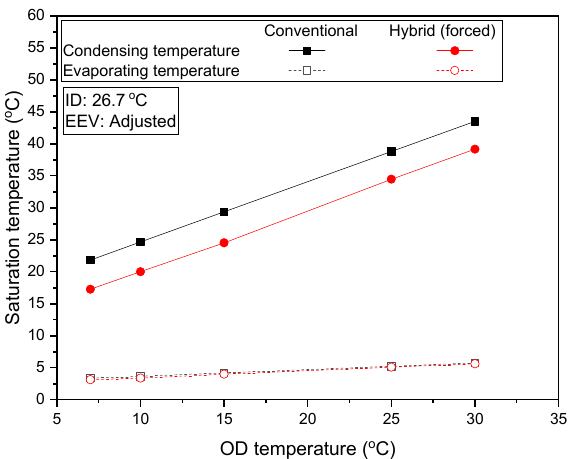
Figure 9. HX temperature comparison for novel hybrid IDC cooling and conventional IDC cooling system.